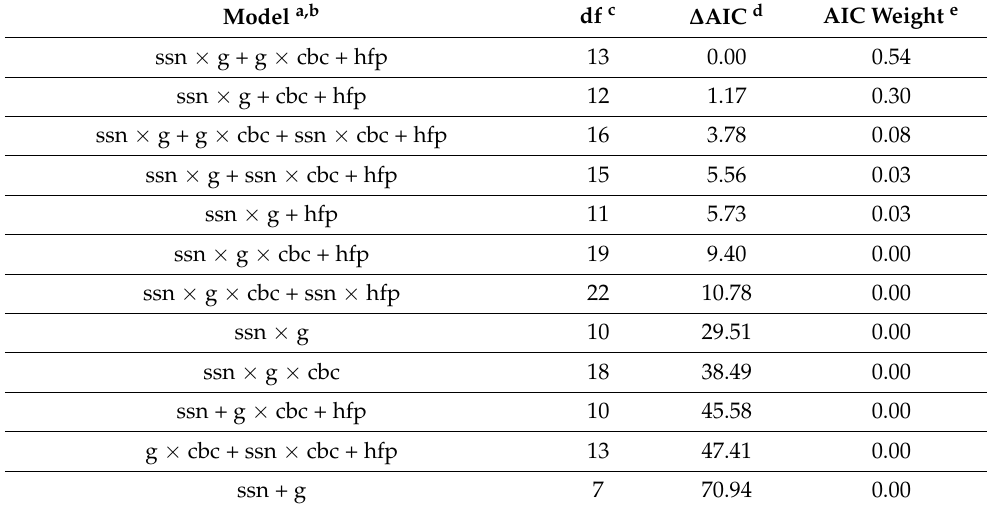
Table 3. Linear mixed models of seasonal home ranges and used areas on the migratory flyway of American White